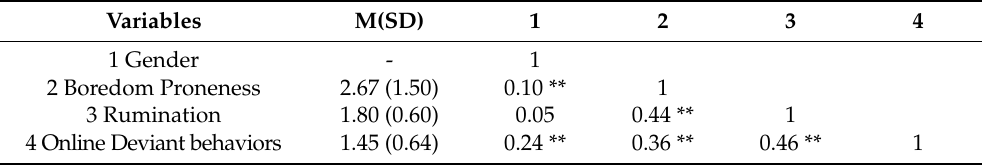
Table 1. Means, standard deviations, and correlation